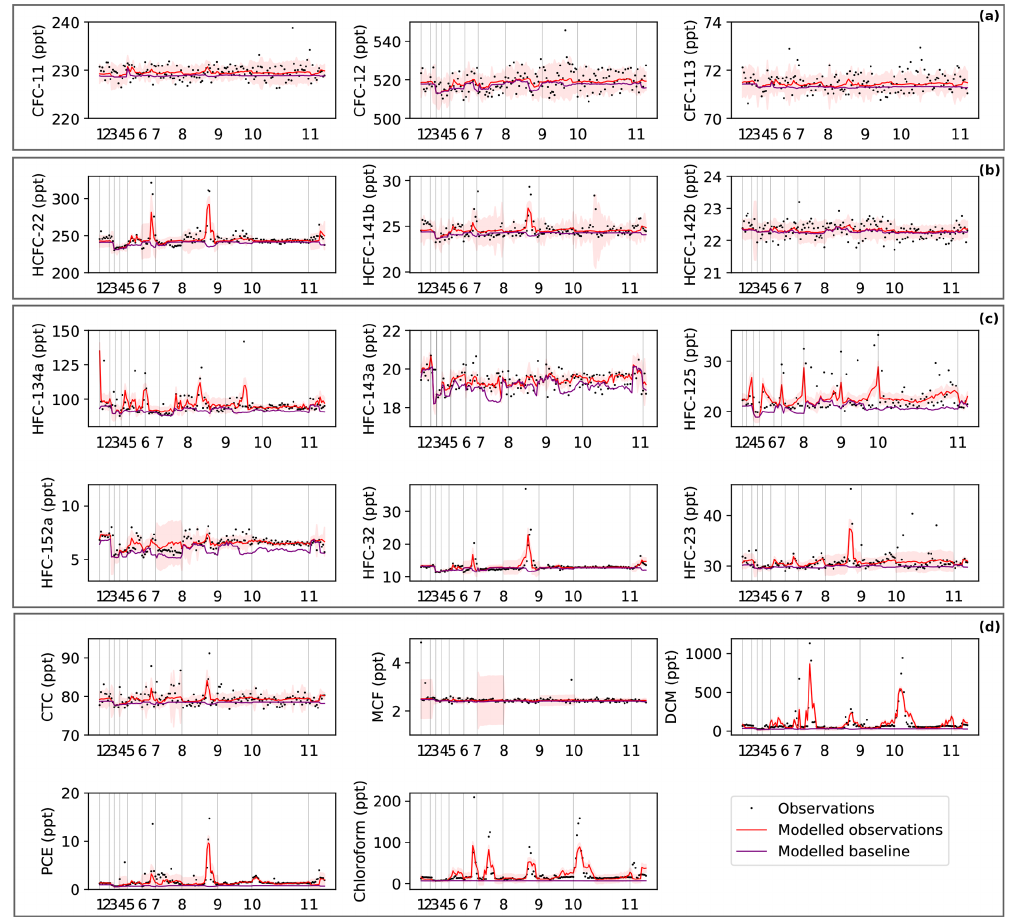
Figure 5. Comparison of measured (black points) with posterior modelled (red line) halocarbon mole fraction data, plotted on a flight by flight basis (a summary of flights 1–11 is given in Table 2). The posterior modelled baseline is also shown (purple line). The shading represents the model uncertainty (5th–95th percentile of the posterior PDF). With the exception of chloroform, for which prior emissions were distributed uniformly over ocean and land, prior emissions were distributed according to the NOAA night-light distribution. Note that for HFC-152a and MCF the y axis has been reduced in comparison to Fig. 2 for